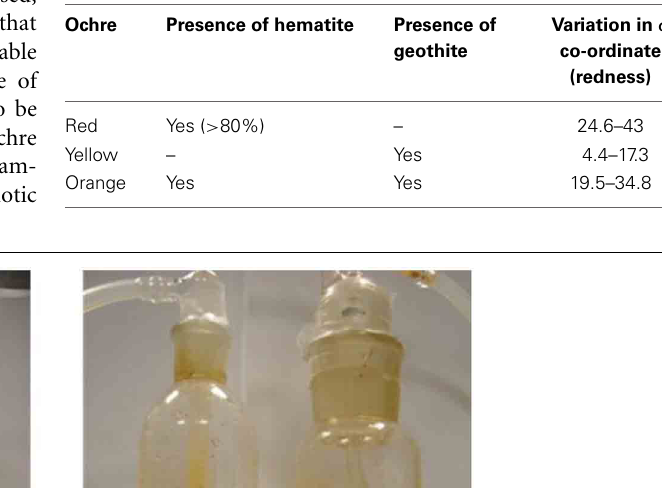
Table 2 | Relationship between color of ochre and its composition (Elias et al., 2006).